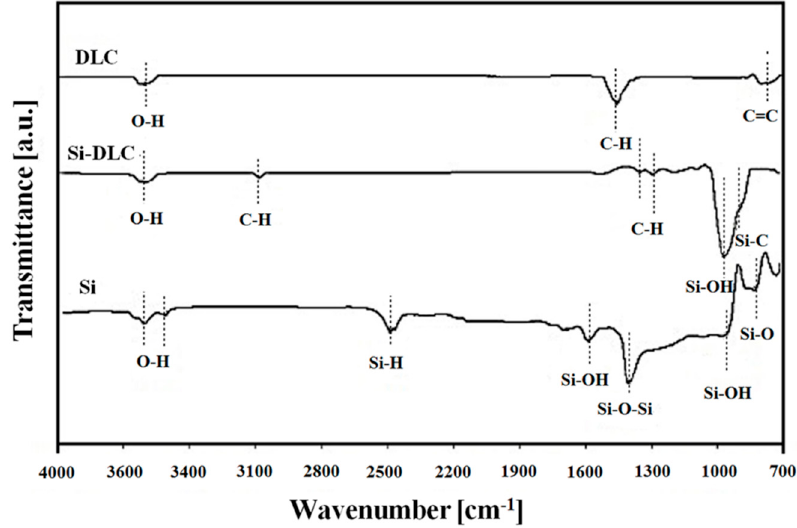
Figure 3. Fourier transformed infrared spectroscopy (FTIR) comparative study of diamond-like carbon (DLC), silicon-incorporated DLC (Si-DLC) and Si surfaces.